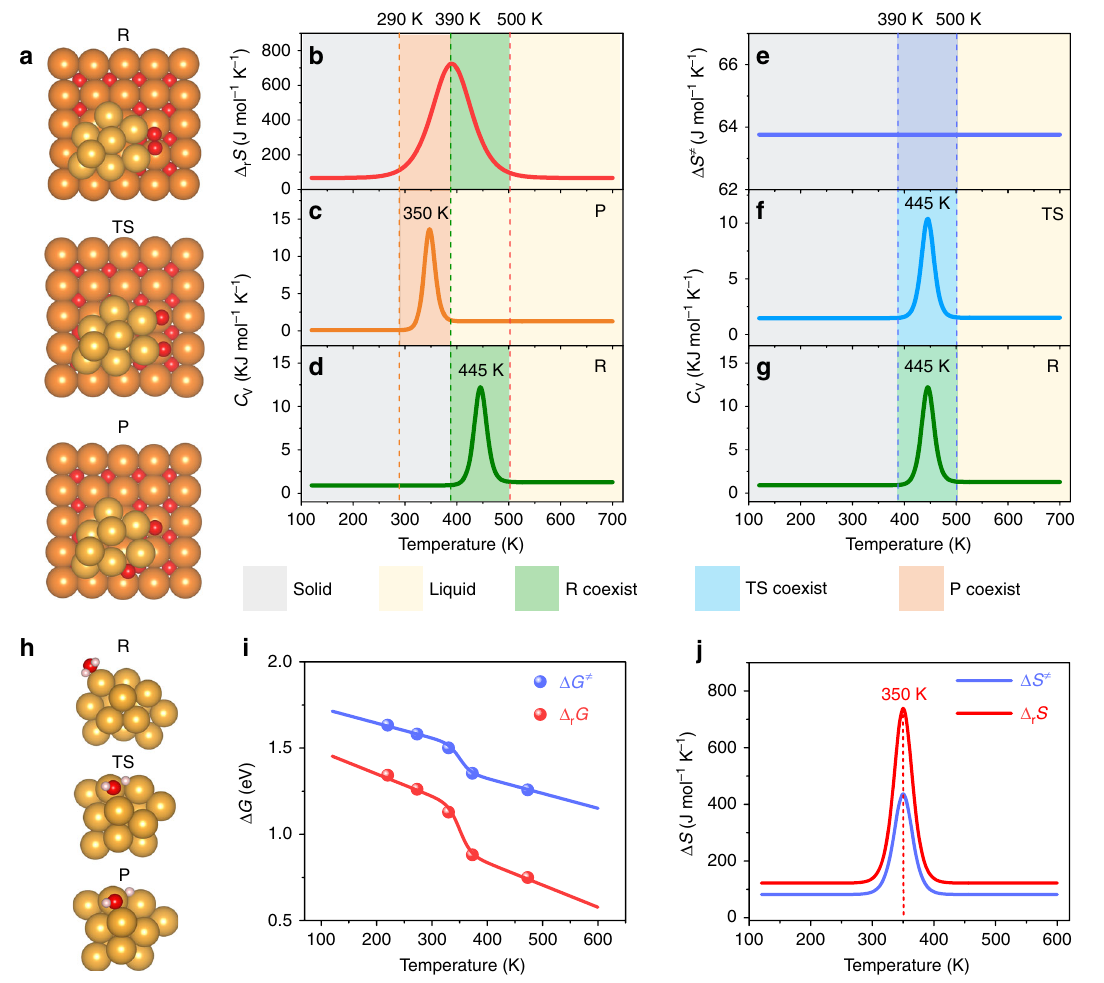
Fig. 3 Calculation of O 2 dissociation on Au 8 /MgO and H 2 O dissociation on Au 13 . a Snapshots of the structures of O 2 dissociation on Au 8 /MgO calculated using AIMD at 220K. R, TS and P denote the reactant, transition state and product state, respectively. The balls in yellow, red and orange represent Au, O and Mg atoms, respectively. b Temperature dependence of the reaction entropy change ( Δ r S). c , d The C v (T) curve of the product and reactant, respectively. e Temperature dependence of the activation entropy ( Δ S ‡ ). f , g The C v (T) curve of the TS and reactant, respectively. The melting temperatures at the peaks are indicated as the inserted values. h Snapshots of the structures of the reactant, TS and product of H 2 O dissociation on Au 13 calculated using AIMD at 220 K. The balls in yellow, red and white represent Au, O and H atoms, respectively. i Temperature dependence of the reaction free energy ( Δ r G) and free energy barrier( Δ G ‡ ). The dots show the calculated values and the lines are fi tting curves. j Temperature dependence of the reaction entropy change ( Δ r S) and activation entropy ( Δ S ‡ ). The insert value indicates the temperature of maximum entropy